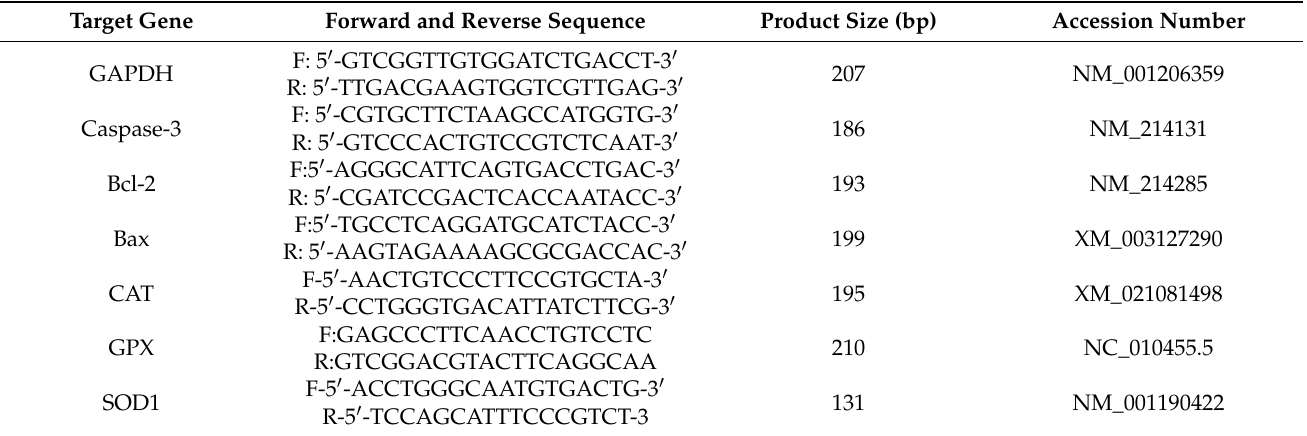
Table 1. Primer sequences of the target genes used for